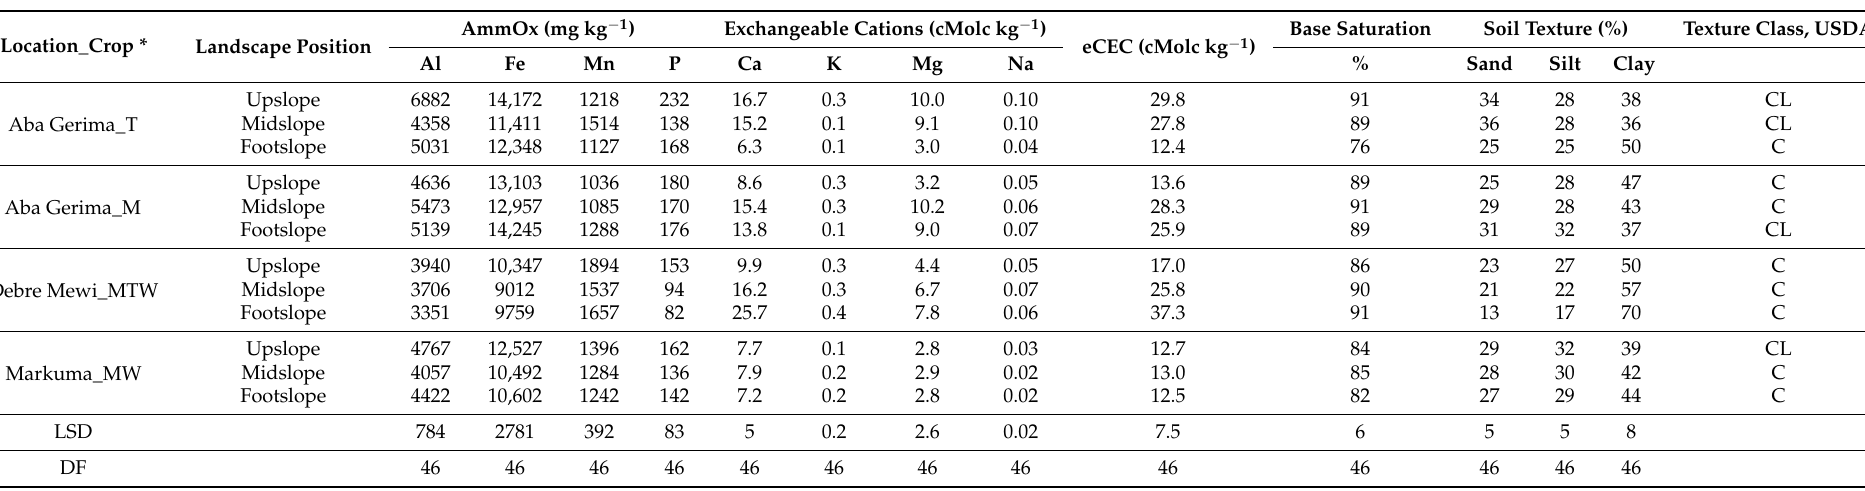
Table 2. Ammonium-Oxalate extractable (Al, Fe, Mn and P), exchangeable cations (Ca, K, Mg and Na), effective cation exchange capacity (eCEC), base saturation and soil texture. Shown are average values from 5 fields per each site in the same landscape position. Location_Crop *